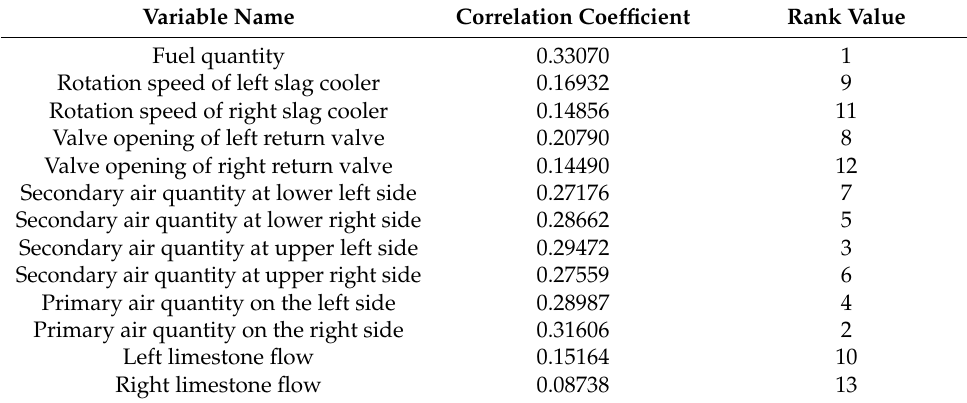
Table 1. The results table of correlation coefficient.